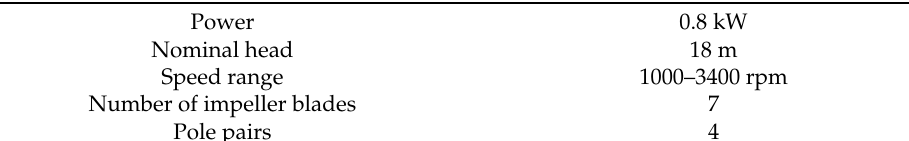
Table 7. Main characteristics of the pump.